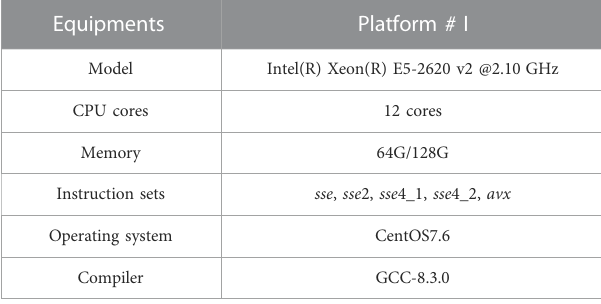
TABLE 1 The con fi guration information of the experimental platform.